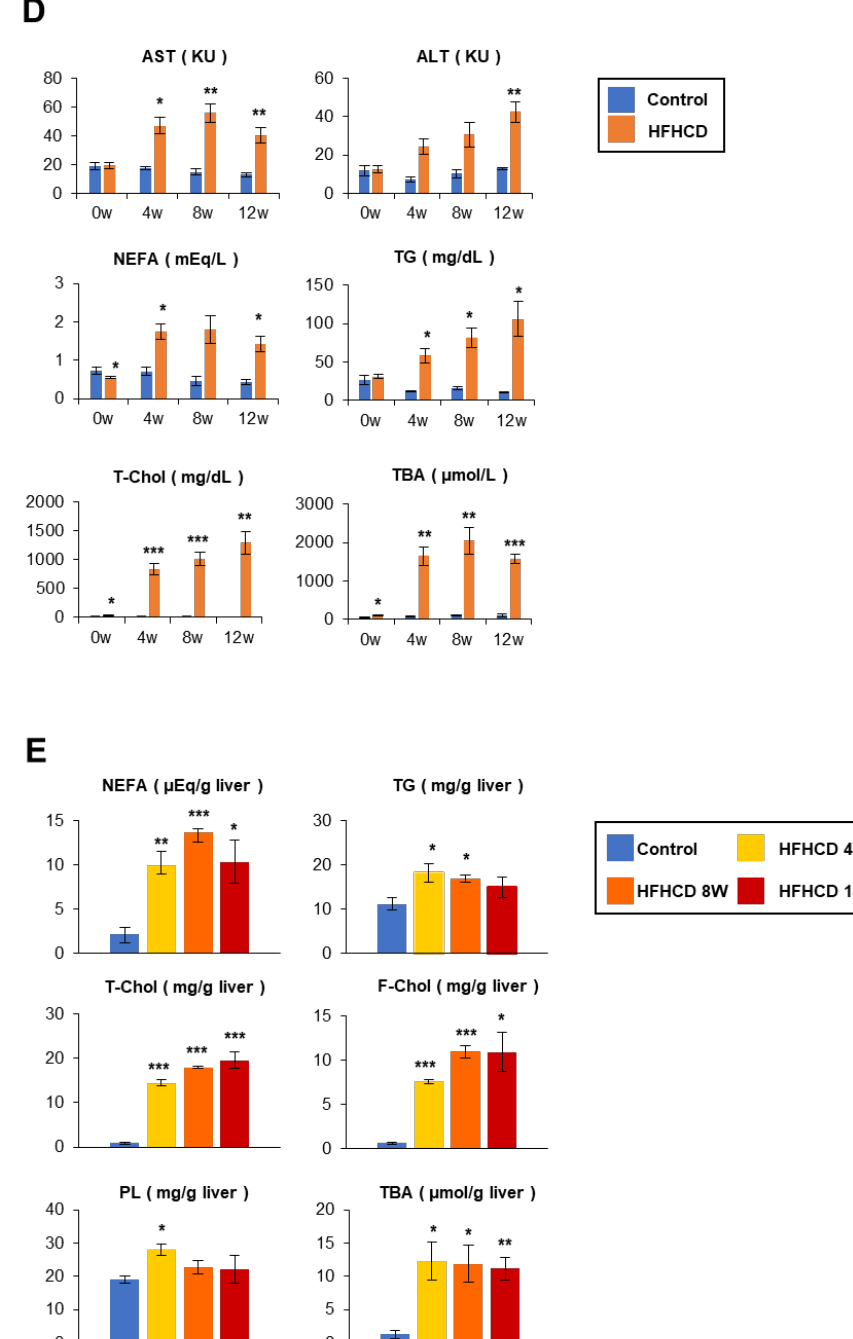
Figure 2. Time–course study of HFHCD-fed rabbits. ( A ) Body weight and liver-to-body weight, spleen-to-body weight ratio. ( B ) Liver tissue and histochemical staining of the liver and aorta of the control and HFHCD-fed rabbits; liver HE staining (left); scale bar = 40 μm, liver Azan–Mallory staining (middle); scale bar = 100 μm, aorta HE staining (right); scale bar = 400 μm. ( C ) Ballooned hepatocyte and crystal structures in 14-week HFHCD-fed rabbit livers. Scale bar = 20 μm. ( D ) Serum biochemical profiles. ( E ) Hepatic lipid and bile acid profiles. Data are shown as the mean ± SEM. * p < 0.05, ** p < 0.01, and *** p < 0.001 vs. control group. Control group (12 weeks, n = 3), HFHCD group; 4 weeks (n = 3), 8 weeks (n = 4), 14 weeks (n = 4).